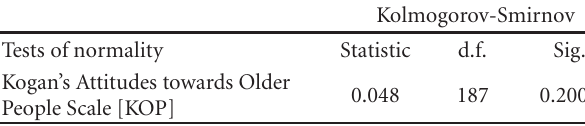
Table 2: Test of normality.